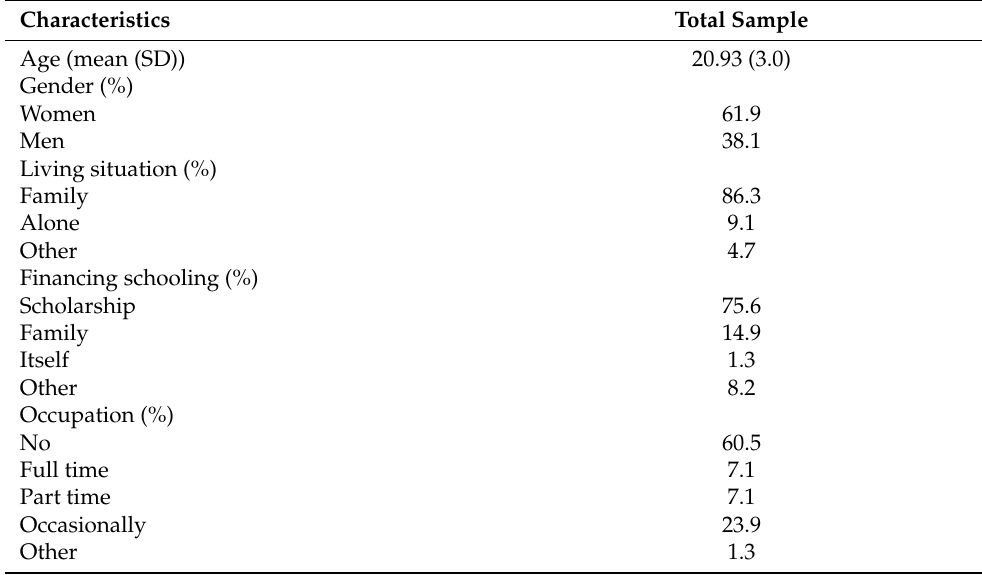
Table 1. Characteristics of the sample ( n =